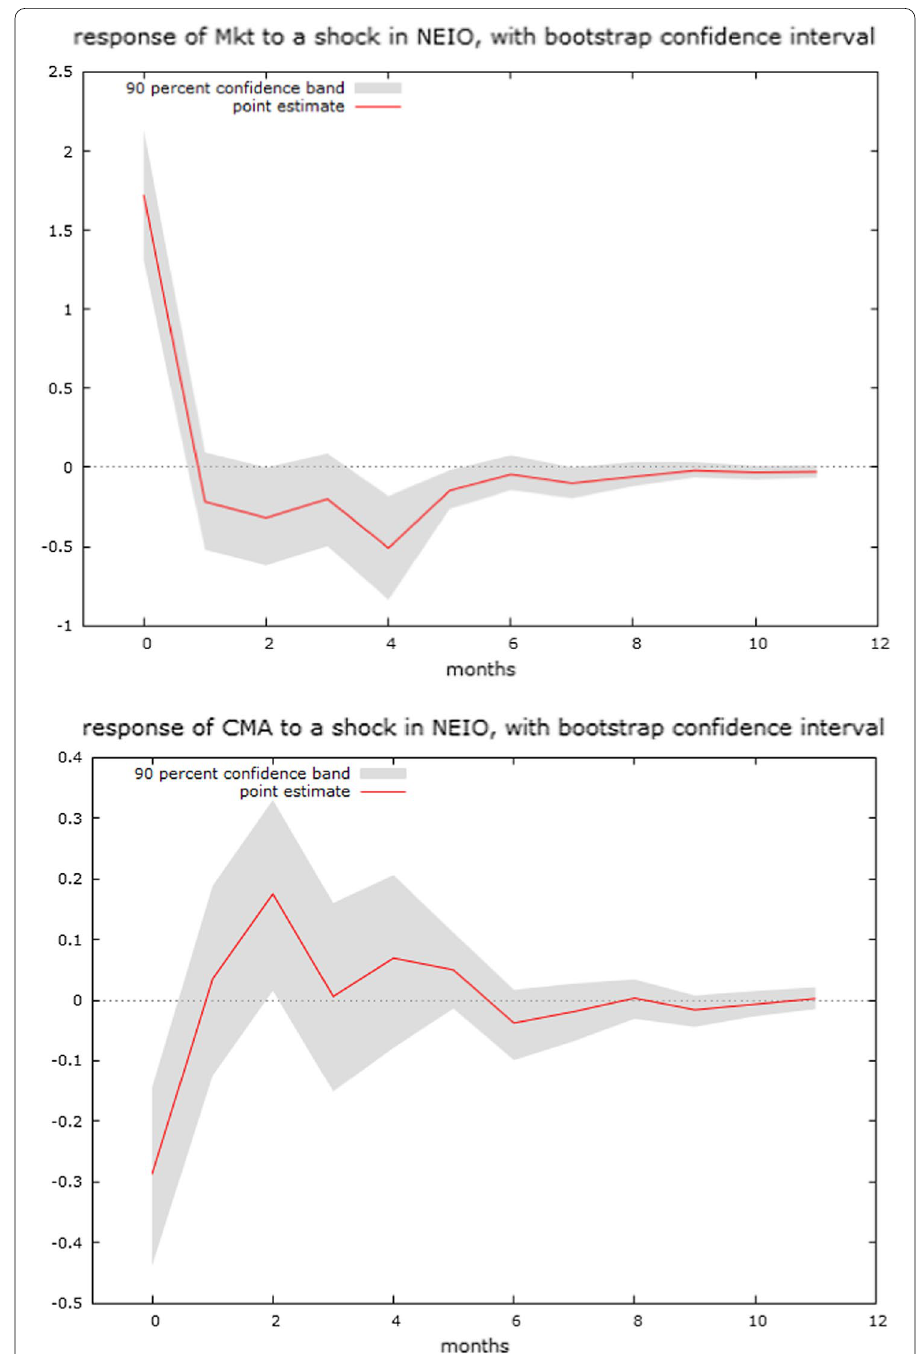
Fig. 1 Impulse responses, Mkt-RF and